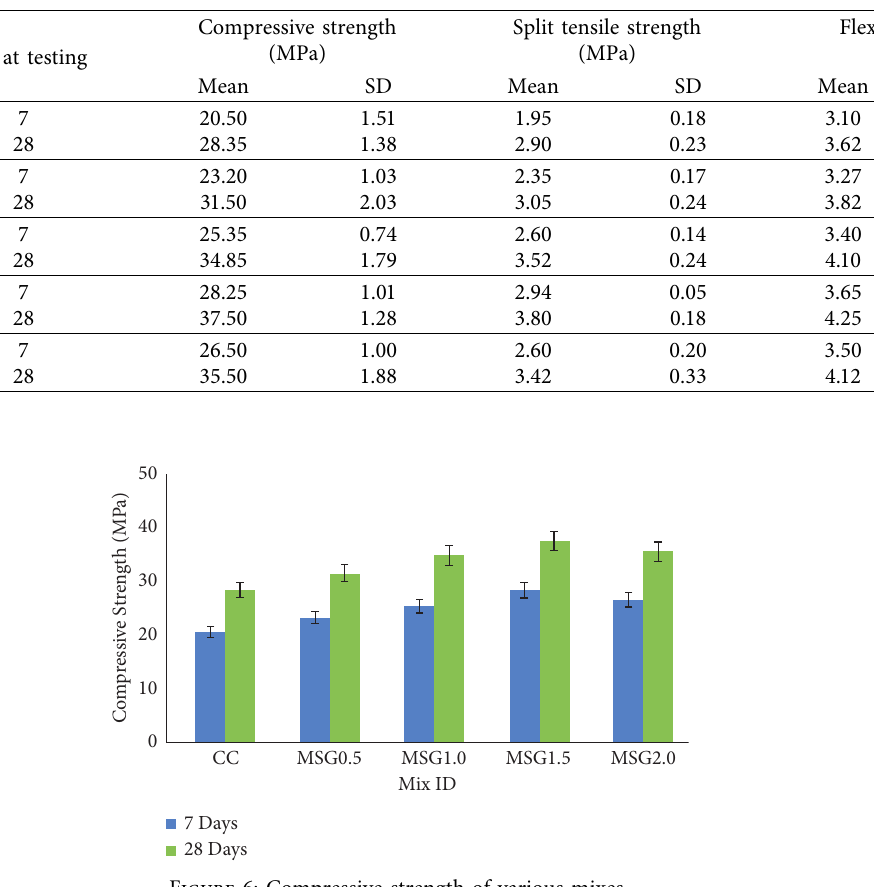
Figure 5: Impact energy test setup. (a) Figure. (b) Schematic figure. Table 2: Strength properties of various